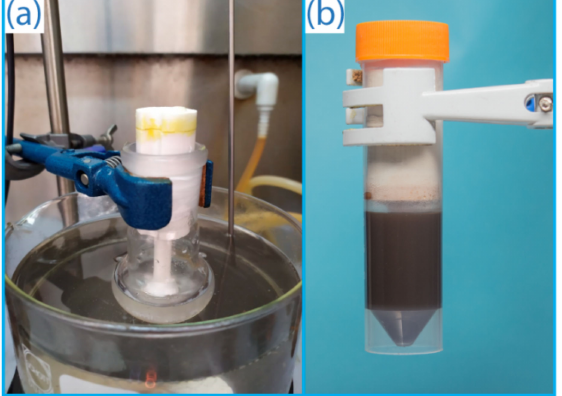
Figure 13. Photos of reaction setups for syntheses of ( a ) vinyl derivatives and ( b ) 1,4-bis(arylthio)buta-